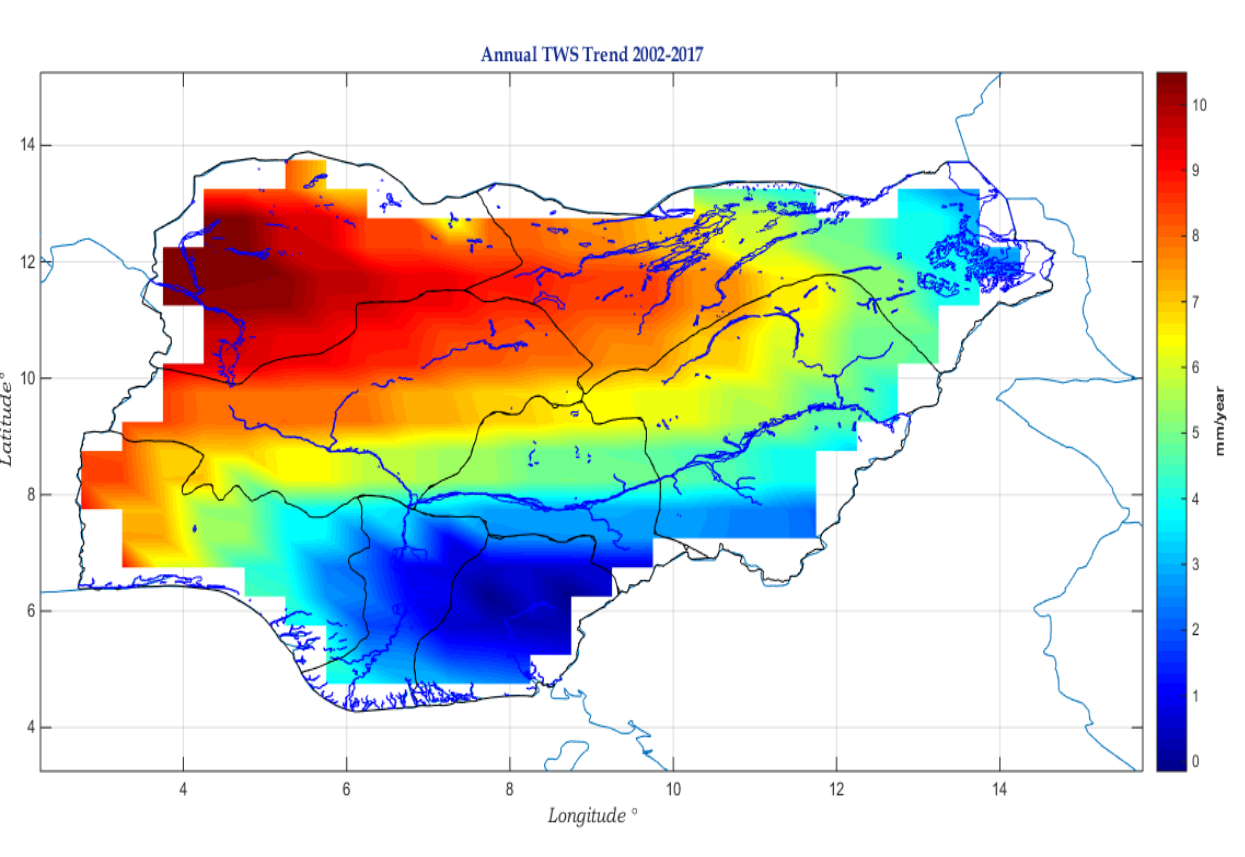
Figure 5. Mean Temporal Seasonal Fluctuations of TWS The minimal values of TWS are observed within the first dry and wet seasons (i.e., January – March; and April – June). This is seen as deficit around Cross River and Anambra Basins. Maximum values are observed around the 2 wet and dry periods (i.e., July- September and October – December) around same river Basin. One clear distinguishable attribute of TWS within Nigeria is the opposite phase phenomenon it displays between the Southern and Northern part of Nigeria in the first dry period. To some extent, this pattern agrees with the projections of Shiru et al (2021) which was explained previously. This stark temporal pattern may be attributed to the lag in the response time between rainfall and TWS. Again, extra research with rainfall data is needed to fully comprehend this pattern in space and time.